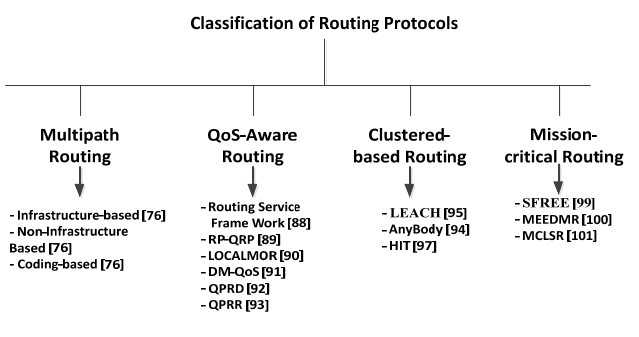
Figure 17. Classifications of Routing